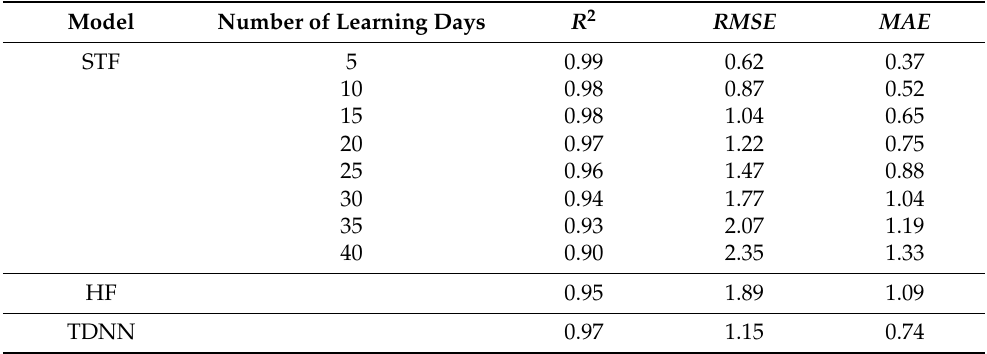
Figure 5. Comparison between the time delay neural network (TDNN) model and the hybrid forecast (HF) model for the +qPCR cases. Table 2. Evaluation metrics of the three forecasting models: short-term forecast (STF), hybrid forecast (HF), and time delay neural network (TDNN) model for the whole COVID-19 pandemic thus far in Jordan, including before and after the emergence of OMICRON